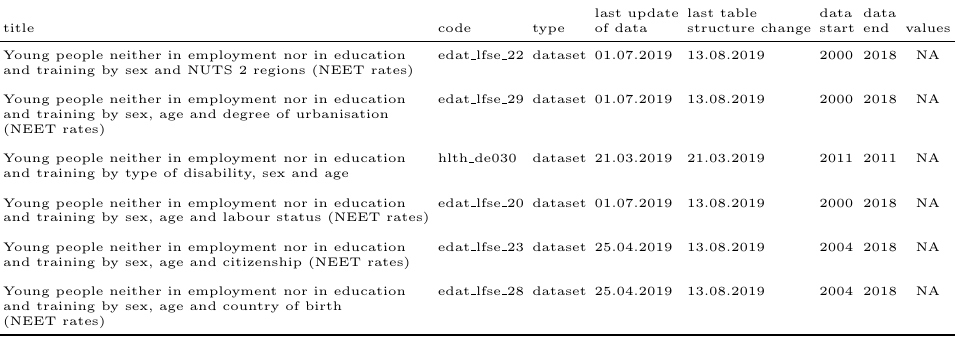
Table 1: Available datasets from Eurostat related to youth